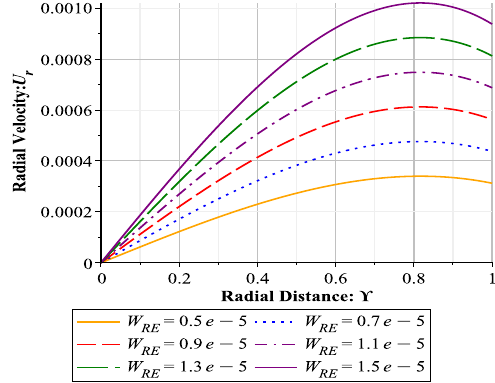
Figure 12. Behavior of U r ( γ ) with γ for different values of W RE